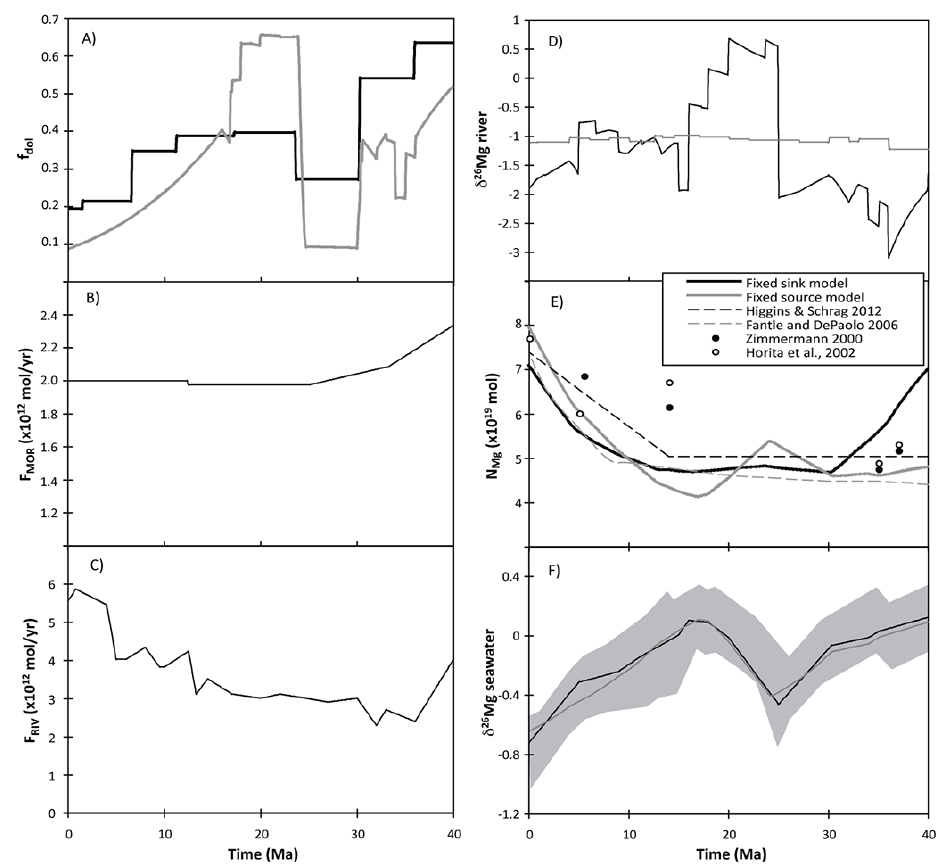
Figure 6. The inputs and outputs from the models (grey line: fixed source model, black line: fixed sink model). (a) Fraction of Mg removed by dolomite, relative to that hydrothermal removal. Due to the relative flatness of the hydrothermal flux at 30Ma, the Mg removal flux by dolomite is essentially parallel to these curves. (b) Mg removal flux at mid-ocean ridges, from estimates of past spreading rates. Both models use these values. (c) riverine input flux, which is identical for both models. (d) Riverine δ 26 Mg. The fixed sink model derives the river δ 26 Mg from the isotope mass balance equation, while the fixed source model derives it from the riverine 87 Sr/ 86 Sr (Lear et al., 2003). (e) Model output seawater Mg reservoir. The dashed lines represent other models (Fantle and DePaolo, 2006; Higgins and Schrag 2012) based on pore waters, and the data points are inferred seawater concentrations from fluid inclusions. (f) Model results for the seawater δ 26 Mg. The grey band represents the same uncertainty on the seawater δ 26 Mg reconstruction as in Fig.